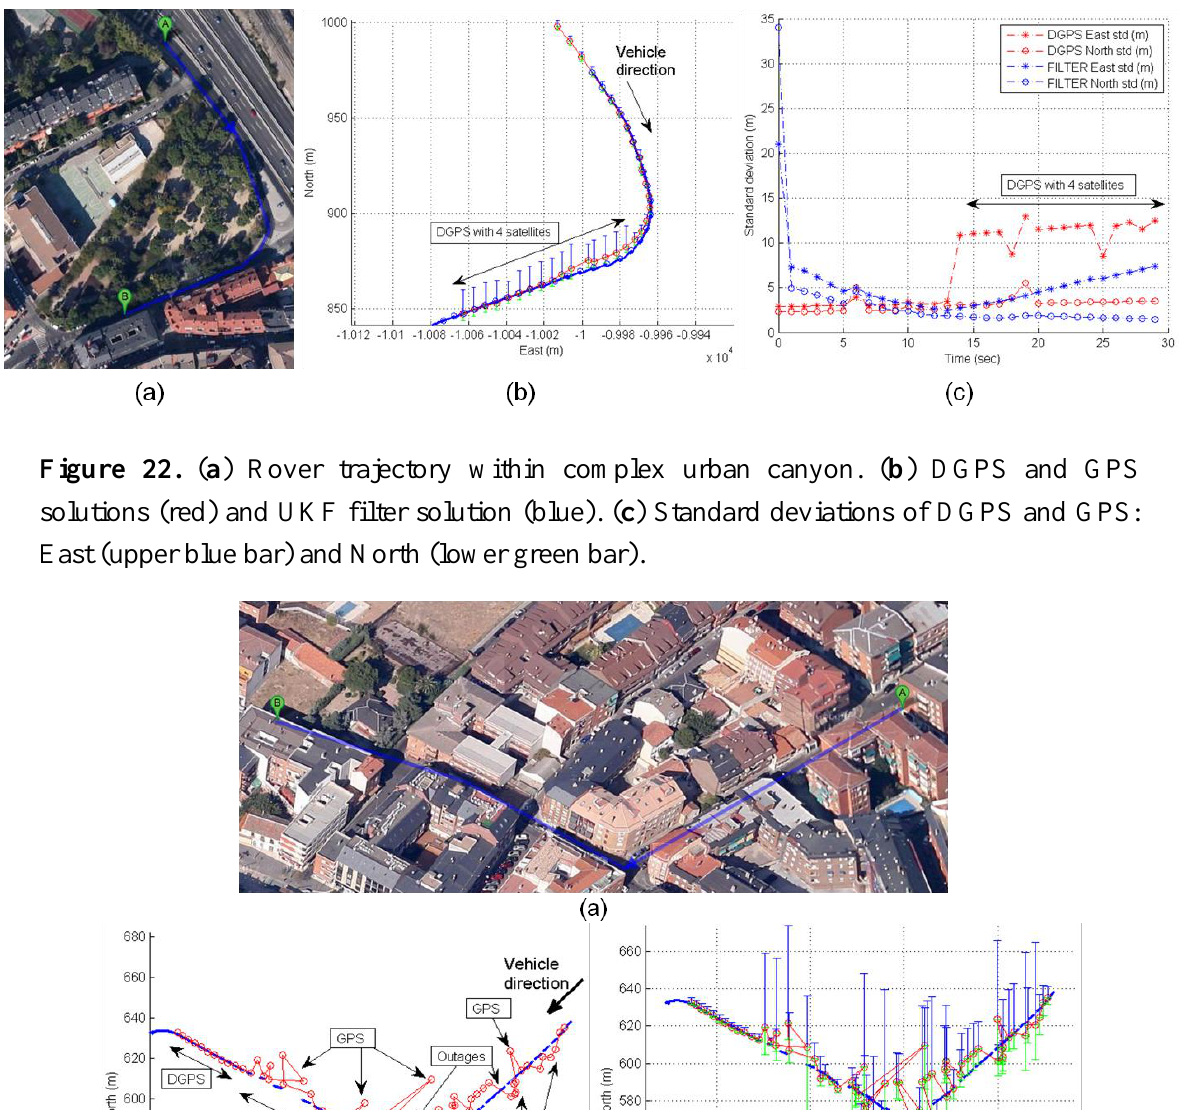
Figure 21. ( a ) Rover trajectory entering in an urban area. ( b ) Loss of accuracy in a soft urban environment (DGPS with four satellites) and UKF filter solution. ( c ) Time-domain standard deviation evolutions (DGPS and filter).